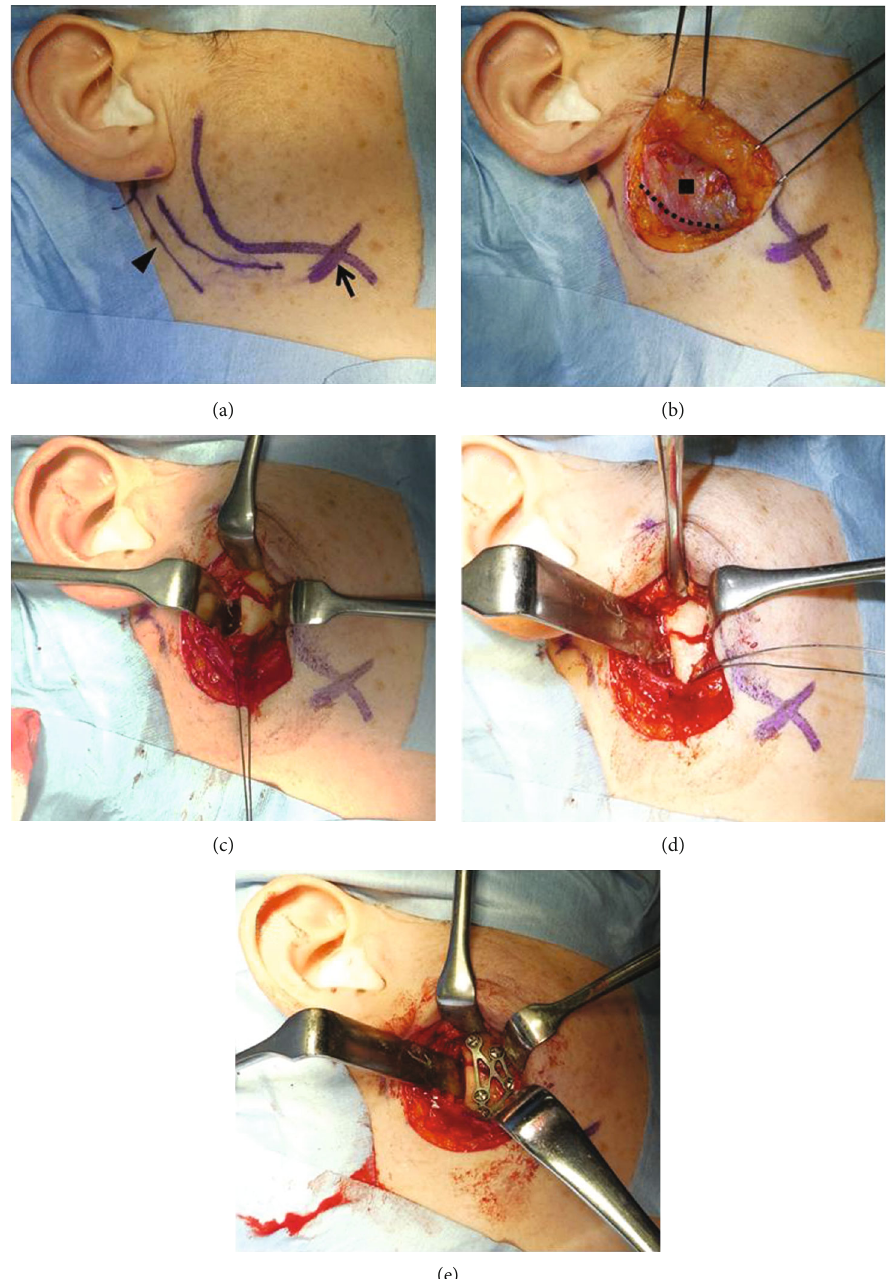
Figure 3: (a) Black arrow: facial artery; black triangle: sternocleidomastoid muscle. The skin incision line, the outline of the mandible, the sternocleidomastoid muscle, and the facial artery are traced using gentian violet. The planned skin incision is 0.5mm caudally from the mandibular margin and 5 to 7 mm posteriorly from the posterior margin of the ramus to include the mandibular angle. An incision line with a total length of approximately 5 cm is made. (b) Black dotted line: platysma incision line; black square: masseter muscle. The platysma fascia is incised, approximately 2 cm subcutaneously, and the fl ap is raised. Once the platysma is located, it is incised to the depth of the masseter fascia such that the incision is 1 cm cranial from the mandibular margin in the anterior direction and 2 cm cranial from the mandibular margin in the posterior direction. In women, the platysma is thin, and the masseter fascia lies immediately inside the platysma. (c) A reverse warping muscle retractor is applied to the posterior margin of the ramus to gently extrude the parotid gland backward, and the masseter muscle is pulled slightly forward with the muscle retractor to expand the operative fi eld. The periosteum is delaminated from the posterior margin of the ramus using a raspatorium, and the fracture site is located. A 0.5-mm-diameter metal wire for pulling the mandibular ramus is passed through caudally to approximately 2cm of the fracture line. (d) By pulling the metal wire downward, the ramus is pulled su ffi ciently downward, and reduction is achieved. (e) After reduction, the fragment is fi xed using a MatrixMANDIBLE Subcondylar Strut